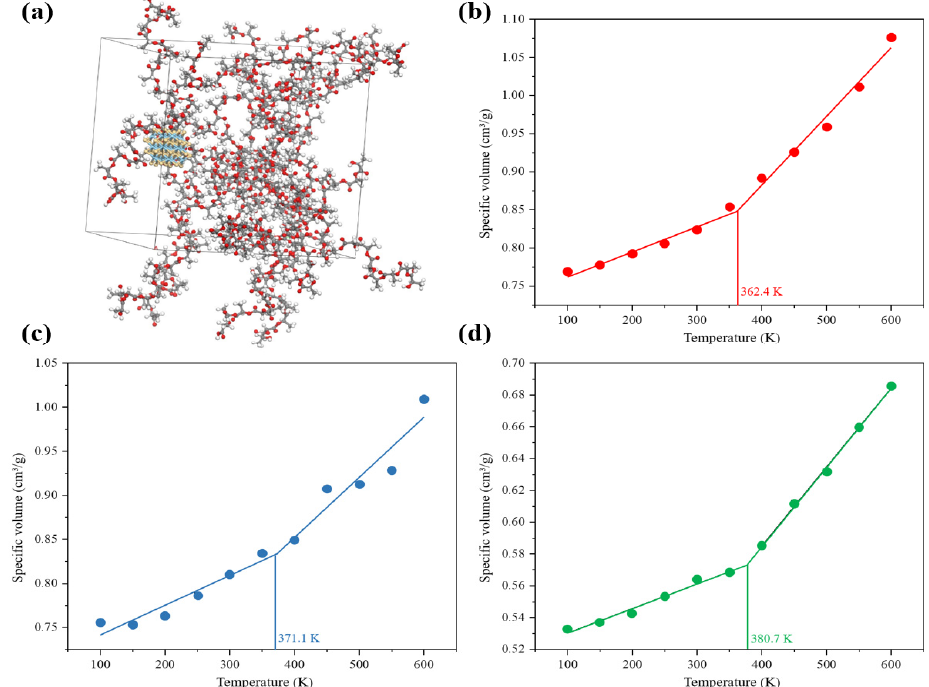
Figure 5. Specific volume of each system model. ( a ) Calculation model of MgO/PLA composites; ( b ) Change of specific volume of MgO/PLA composites with particle size of 3 A; ( c ) Change in specific volume of MgO/PLA composites with particle size of 5 A; ( d ) Change in specific volume of MgO/PLA composites with particle size of 8 A.